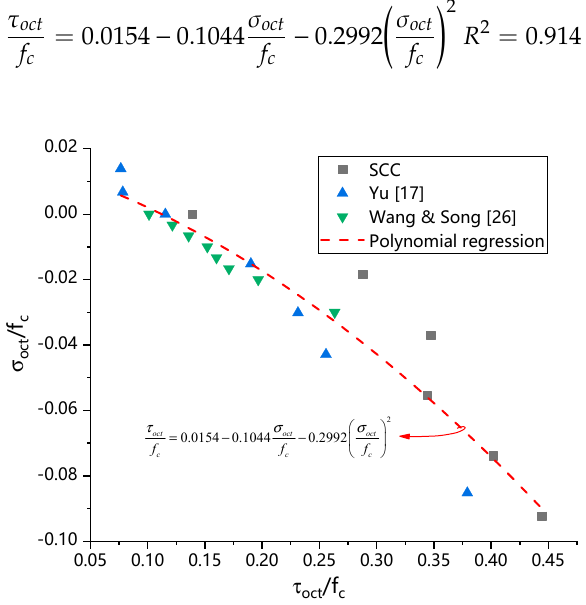
Figure 11. SCC failure criterion of octahedral stress space.